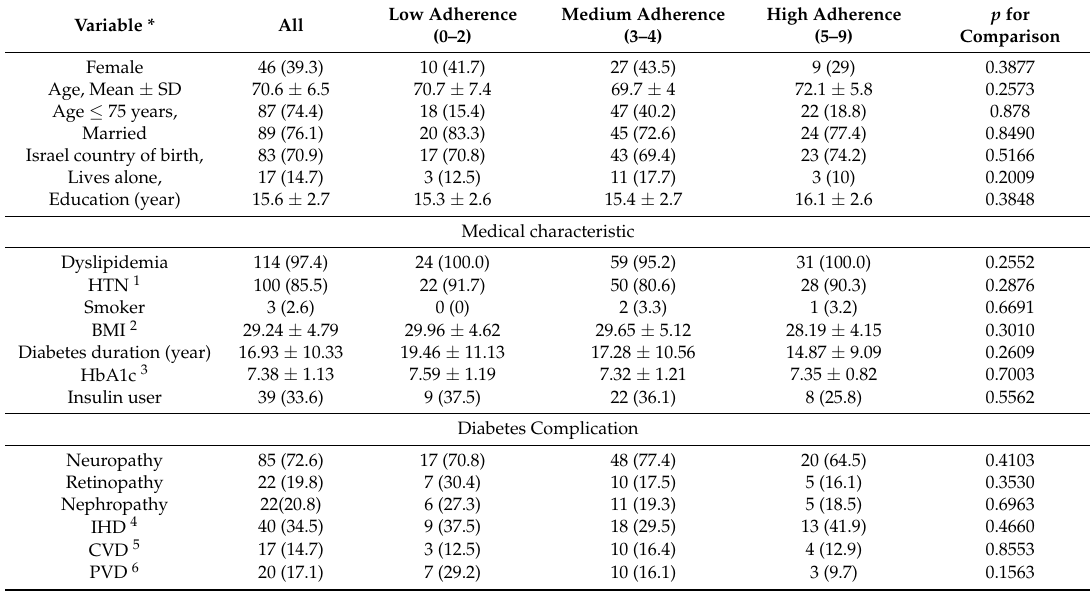
Table 1. Demographic and Medical characteristics according to adherence to MD